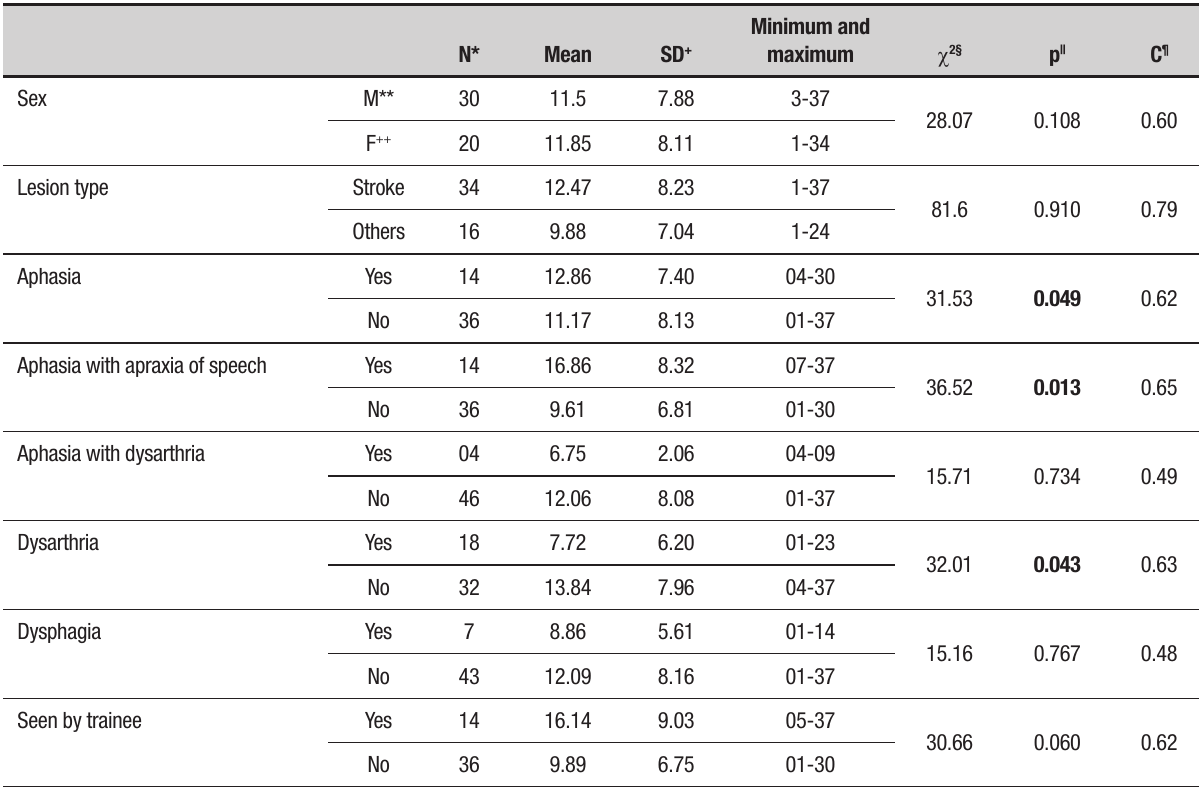
Table 2. Association between therapy time and profession, sex, lesion type, presence of aphasia, apraxia of speech, dysarthria or dysphagia and having been seen by